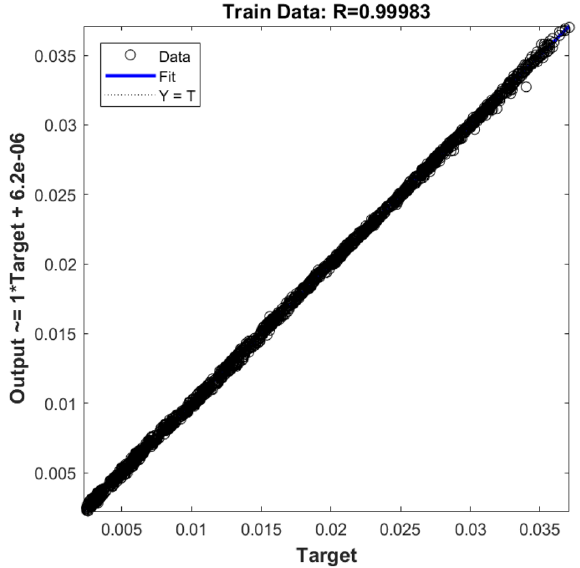
Figure 10. Training validation of fluid velocity for ANFIS model with three inputs (X, Y, and Z computing nodes, the position of numerical elements). The ANFIS model’s output is the liquid velocity distribution, and it is validated against the velocity component (x-direction) in the CFD calculation (target value).